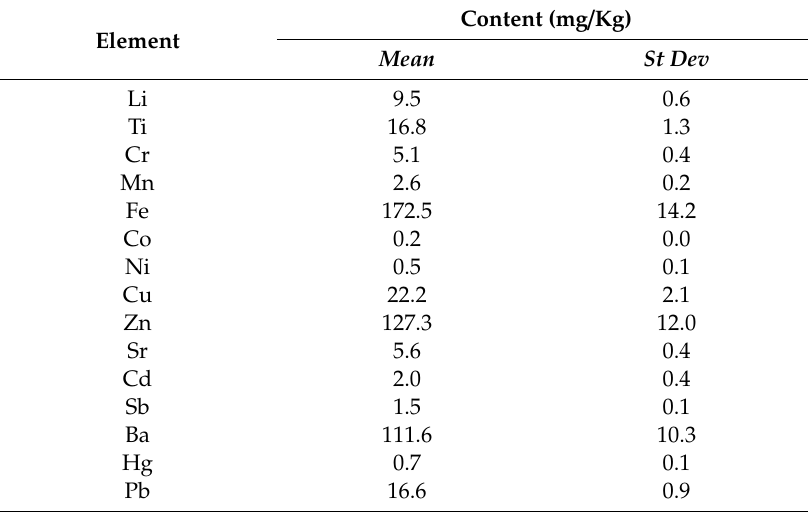
Table 1. Results of ICP.